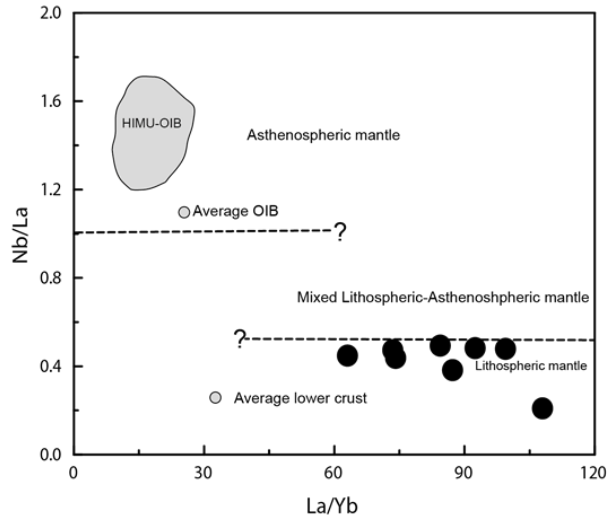
Figure 19. Nb/La versus La/Yb variation diagram. Average OIB is after [51] and average lower crust is after Reference [78]. Dashed lines separating fields of the asthenospheric, lithospheric and mixed mantle are plotted based on data given in Reference [77]. The HIMU-OIB area is reported in Reference [79].